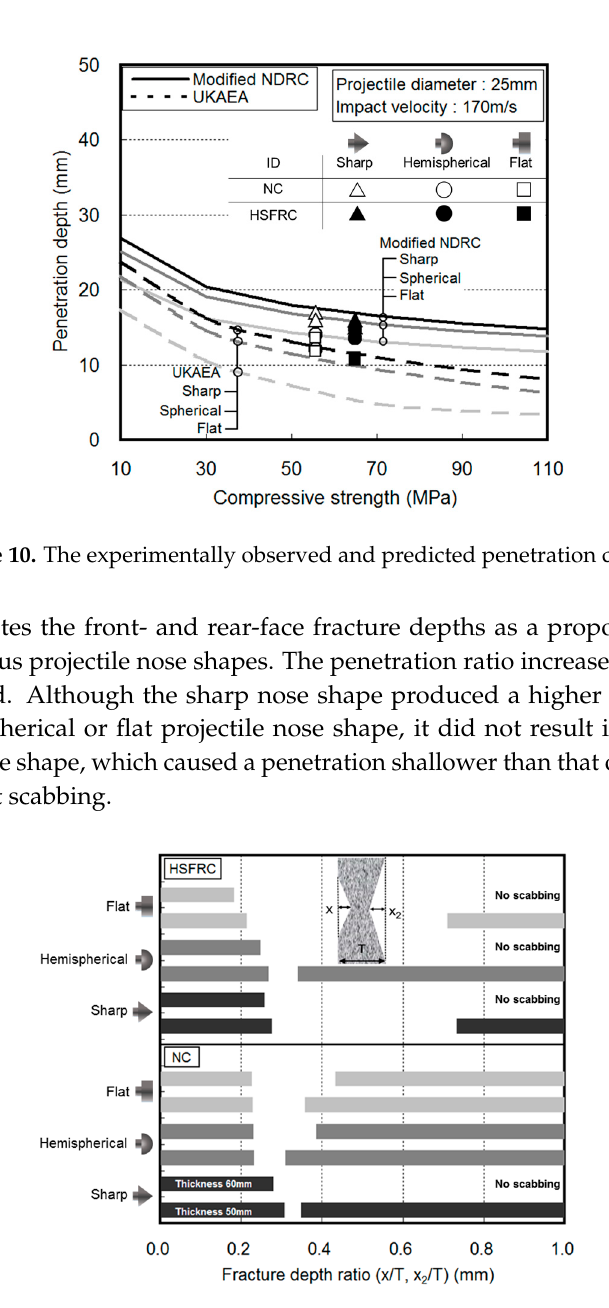
Figure 11. Fracture depth ratio.